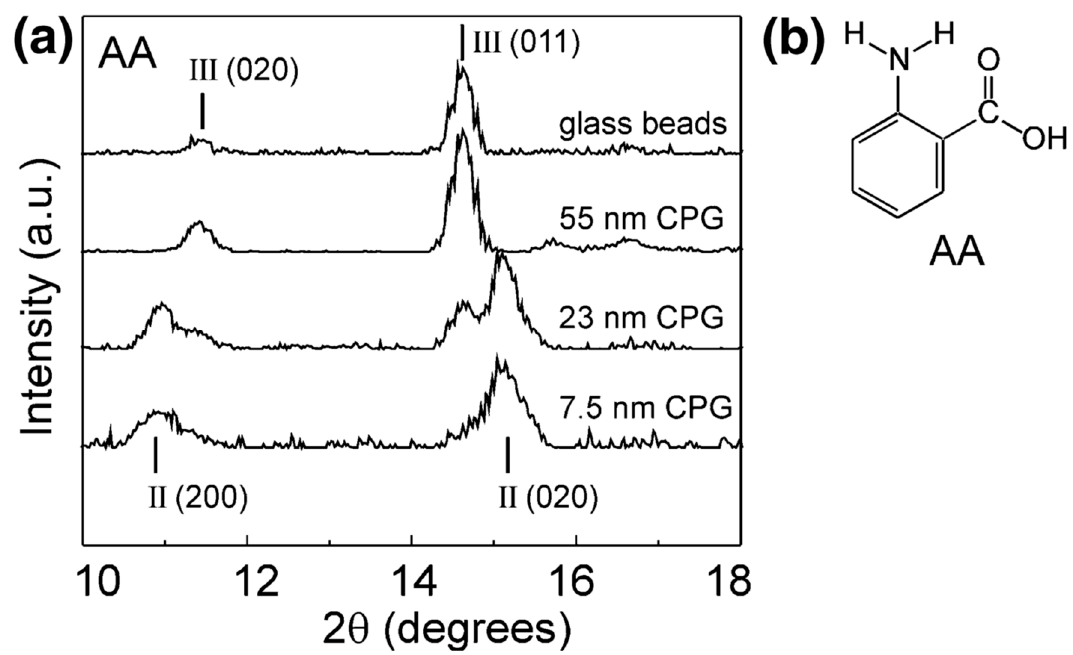
Figure 2. ( a ) X-ray powder diffraction (XRPD) data for anthranilic acid crystallised by cooling of its melt on nonporous glass beads and within controlled pore glasses (CPGs) of various pore sizes. ( b ) Structure of anthranilic acid (AA). Reproduced with permission from [25].